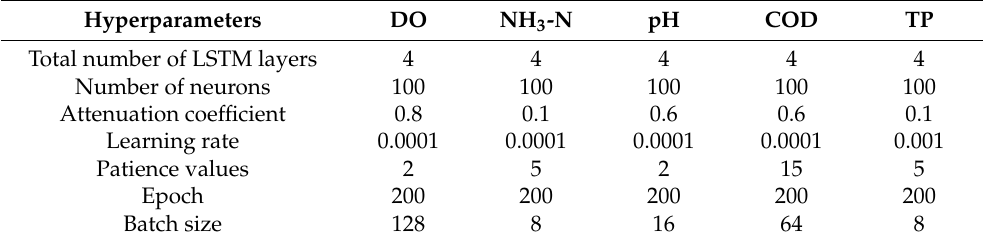
Table 2. Hyper-parameter settings.